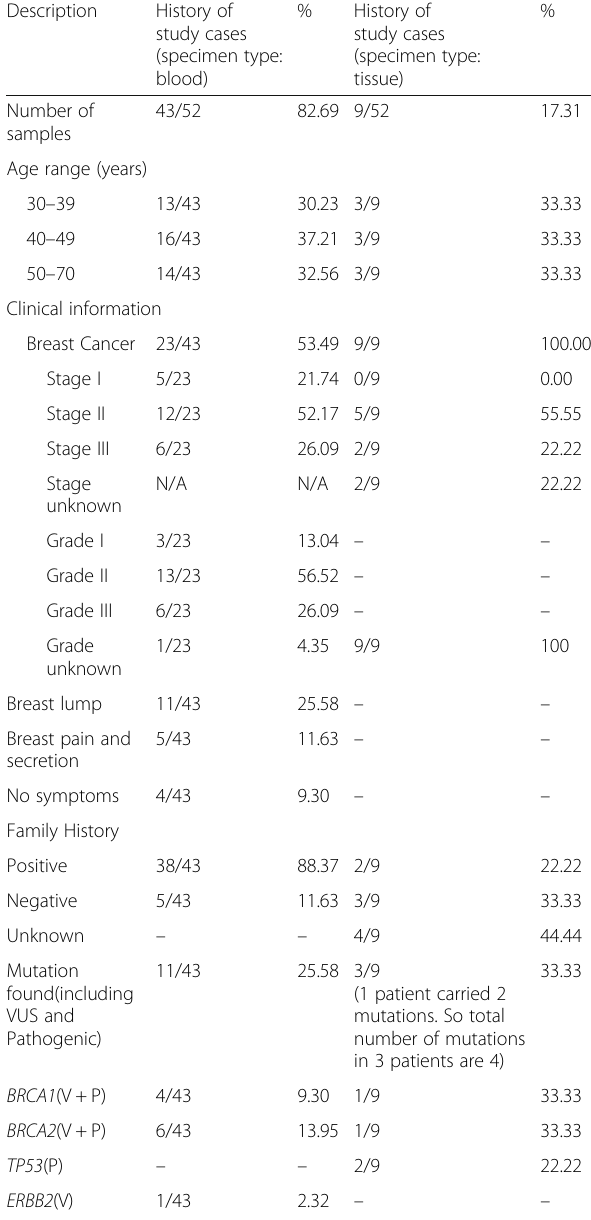
Table 3 Descriptive statistics of the breast cancer